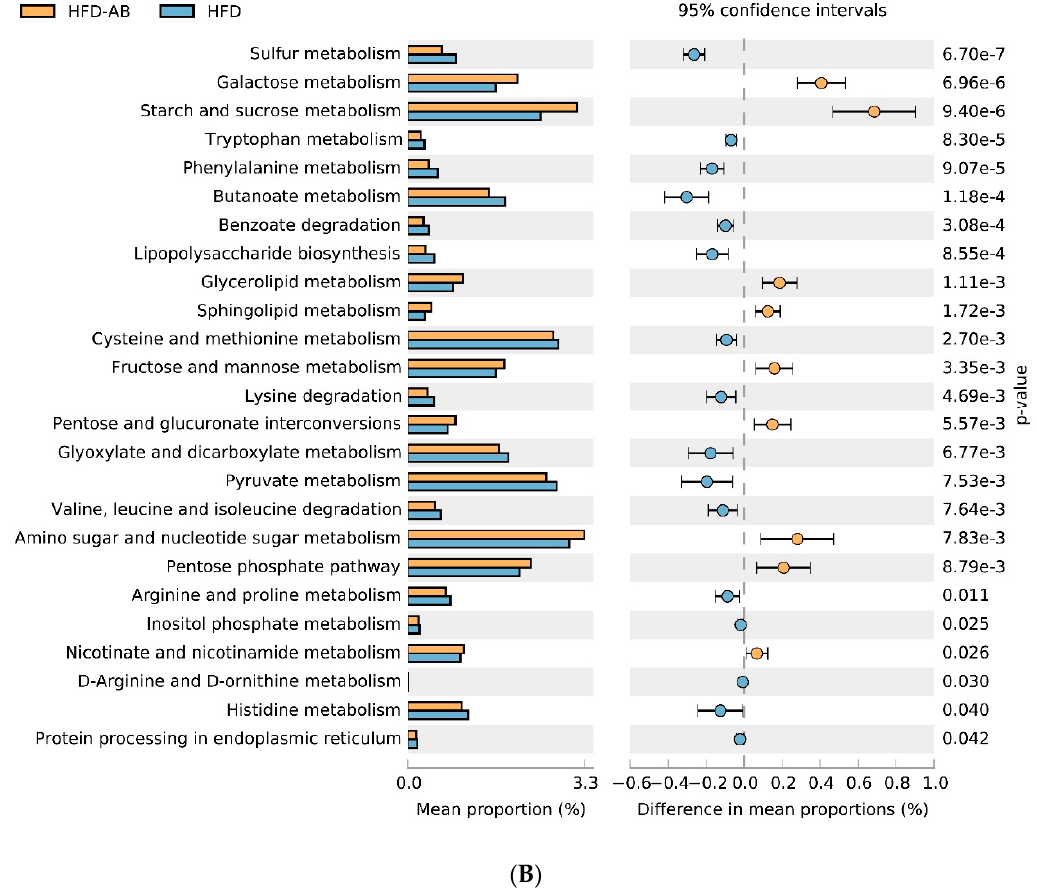
Figure 8. Predicted metabolic profile of the fecal microbiome after different treatments. ( A ) HFD vs. NCD; ( B ) HFD-AB vs. HFD. 16S rRNA data were analyzed as indicated by the PICRUSt2. Statistical significance difference among treatment groups based on Welch’s t -test ( p < 0.05) in STAMP. The colored circles represent 95% confidence intervals calculated using Welch’s inverted method.